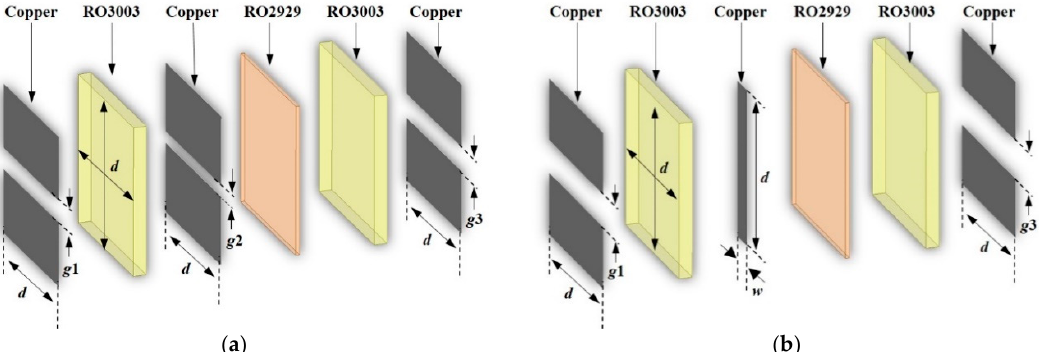
Figure 6. Exploded views and dimension parameters of single-pol, ( a ) low-pass, and ( b ) band-pass unit cells.